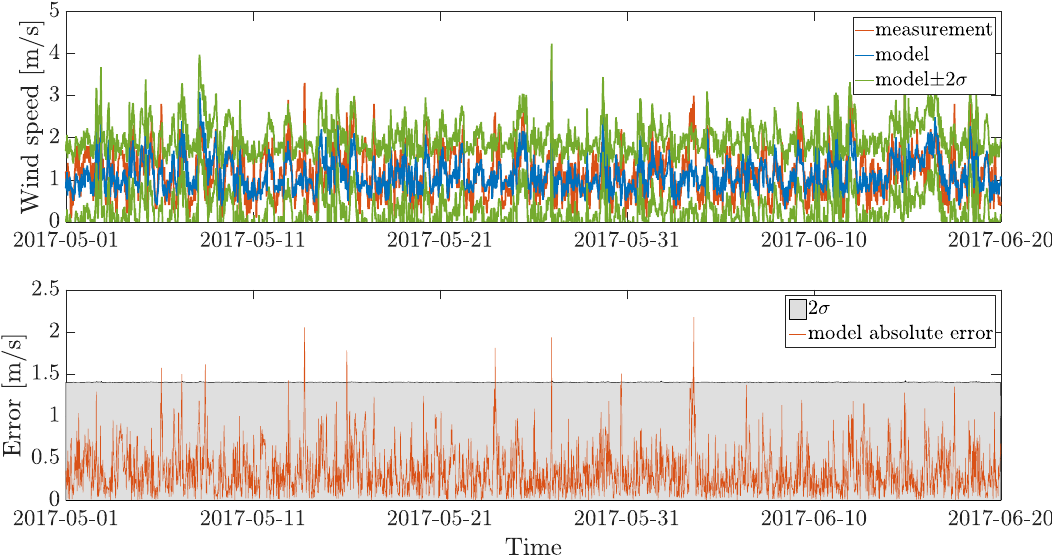
Figure 7. Comparison of measurement and model results Brežice over 50 days of 2017. The model used is a linear regression with least squares model trained on November 2017 data, referred to as Model 11 in Figure